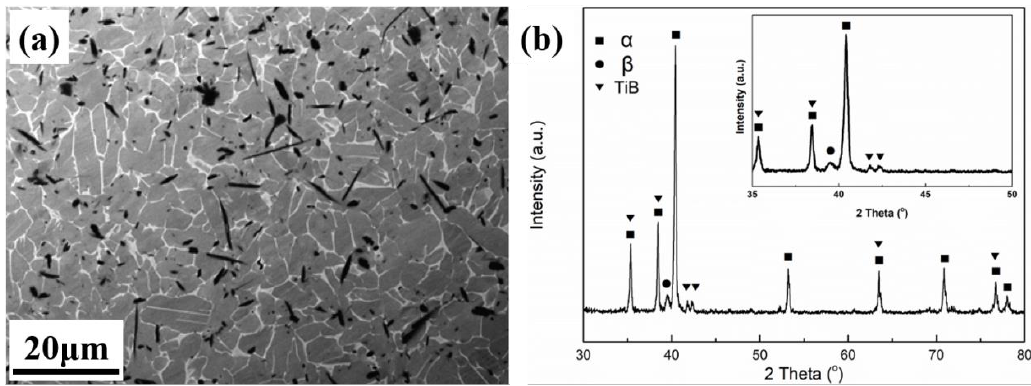
Figure 1. Microstructure and X-ray diffractometer (XRD) patterns of the UF-TiB/Ti-6Al-4V composite: